Question: From the figure, is the trend upward or downward?
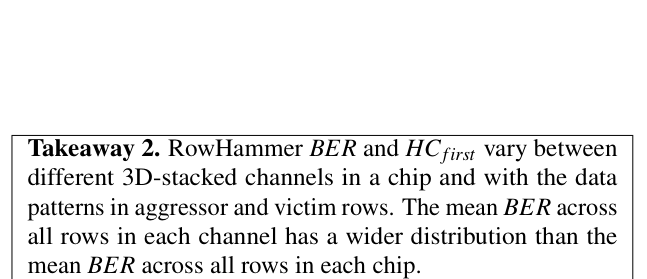
Answer: increasing